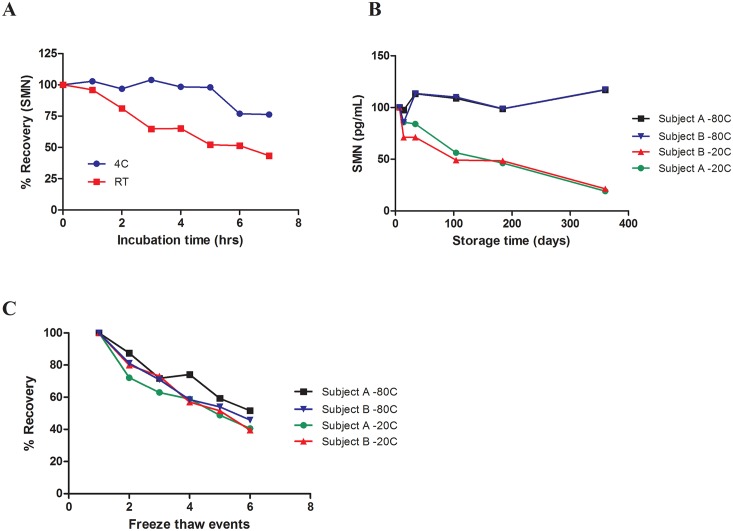
SMN protein stability in whole blood: short term, long term, and freeze / thaw events.Whole blood of healthy subjects was used in the study. (A) SMN protein was measured in previously frozen, undiluted whole blood samples incubated at 4°C or at room temperature. (B) SMN protein was measured in undiluted whole blood samples of two subjects stored at -80°C or at -20°C. (C) SMN protein levels were measured in samples of two subjects that went through freeze-thaw cycles. *FDA acceptance criteria (below 85%).